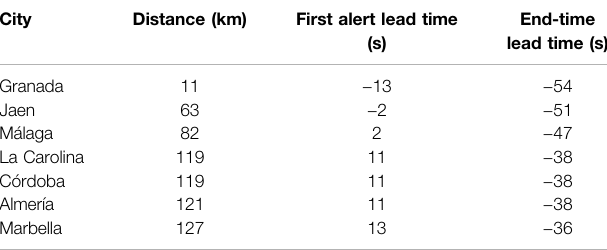
TABLE 2 | Lead times at the seven cities closest to the epicenter for the largest Granada 2021 earthquakes.